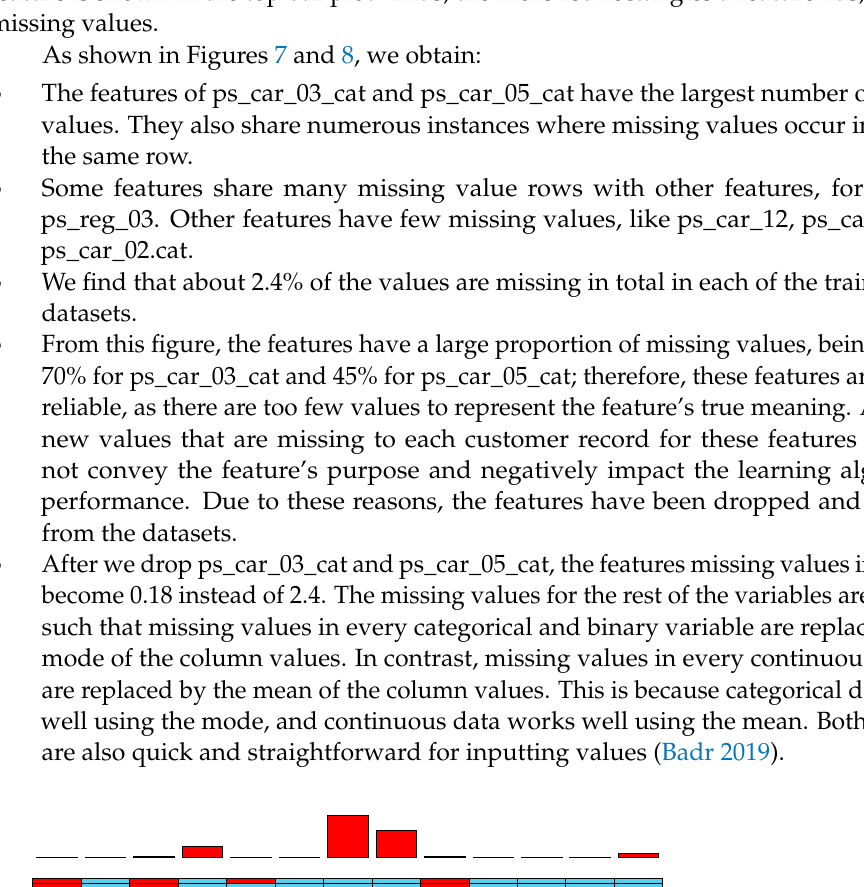
Figure 8. Missing values in our data. 6.1.3. Correlation Overview